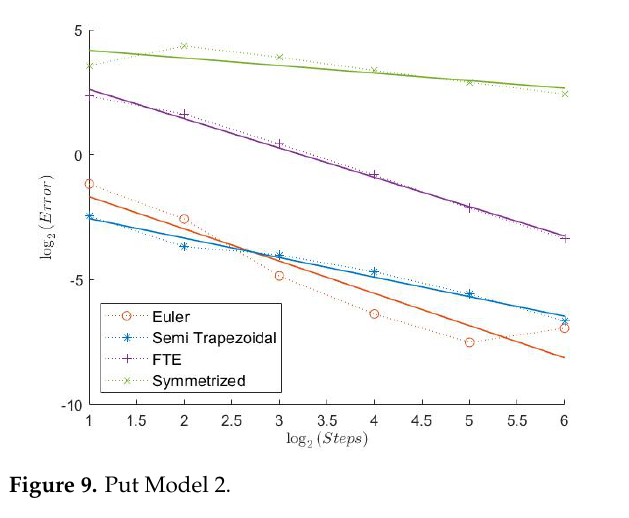
Figure 9. Put Model 2.